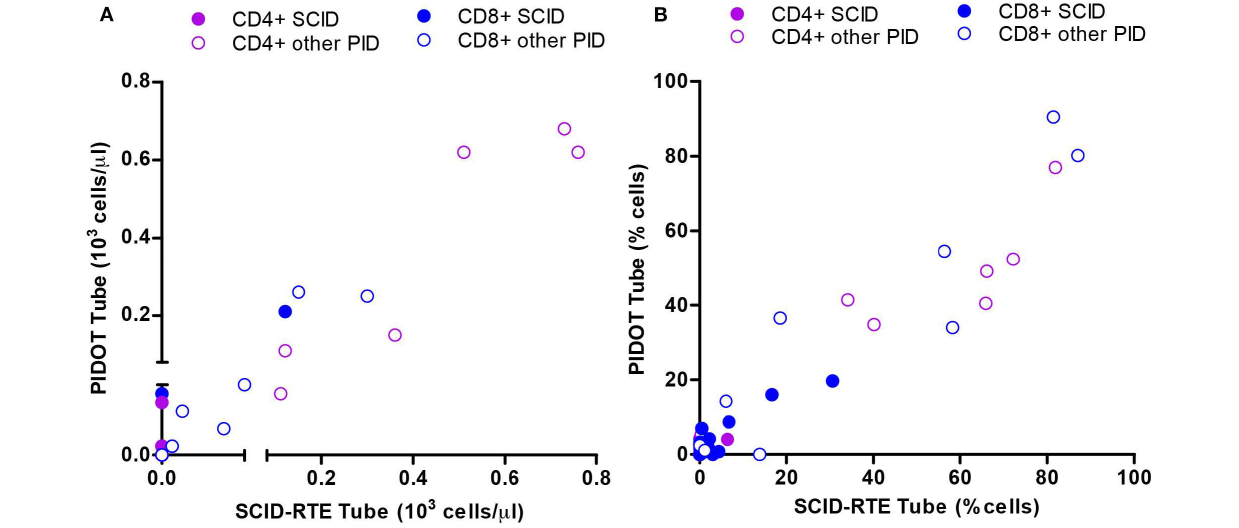
FIGURE 5 | Correlation between the SCID-RTE and the PIDOT tube in determining the levels of naïve CD4 + and CD8 + T-cell subsets in PID patients. (A) Absolute counts or (B) Relative counts for each PID patient ( n = 24) of naïve CD4 + T-cells (blue) and naïve CD8 + T-cells (green) measured by the SCID-RTE tube (x axis) and the PIDOT tube (y axis). SCID (closed circles), other PID (open circles) patients. Detailed gating strategy is shown in Supplemental Figure 1